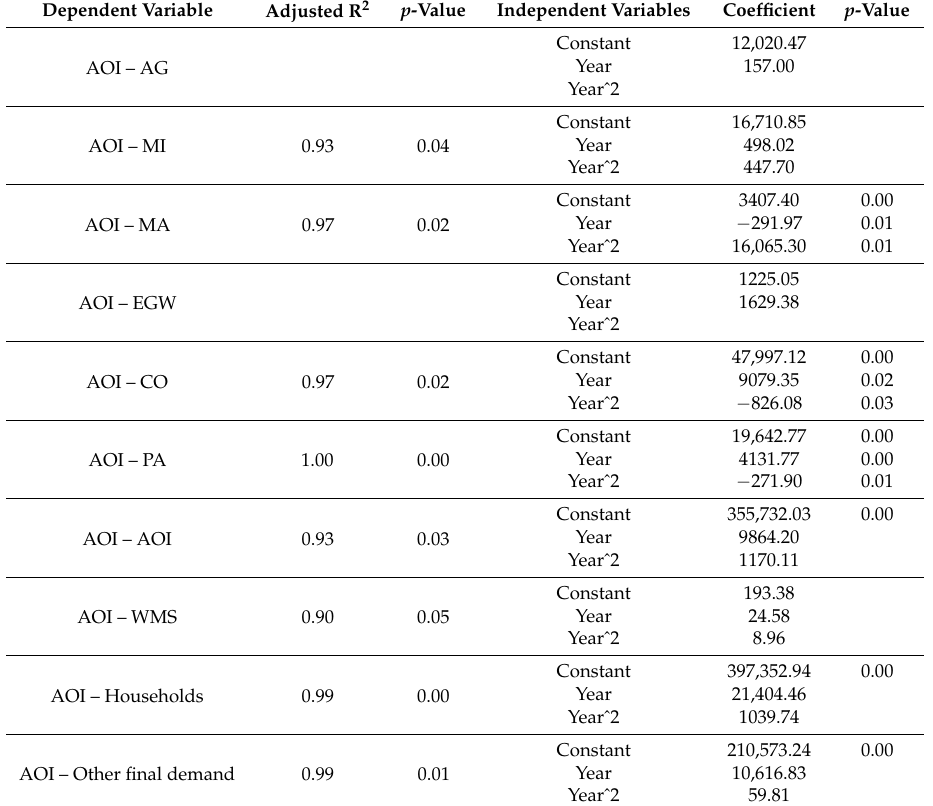
Figure 4. Inputs from the AG sector to the CO sector in Equation (4). Agriculture, forestry, and fishing = AG; Construction = CO. Table 3. Regression models with their main characteristics for the AOI sector to intermediate sectors using interpolation, coefficients ( n = 5).